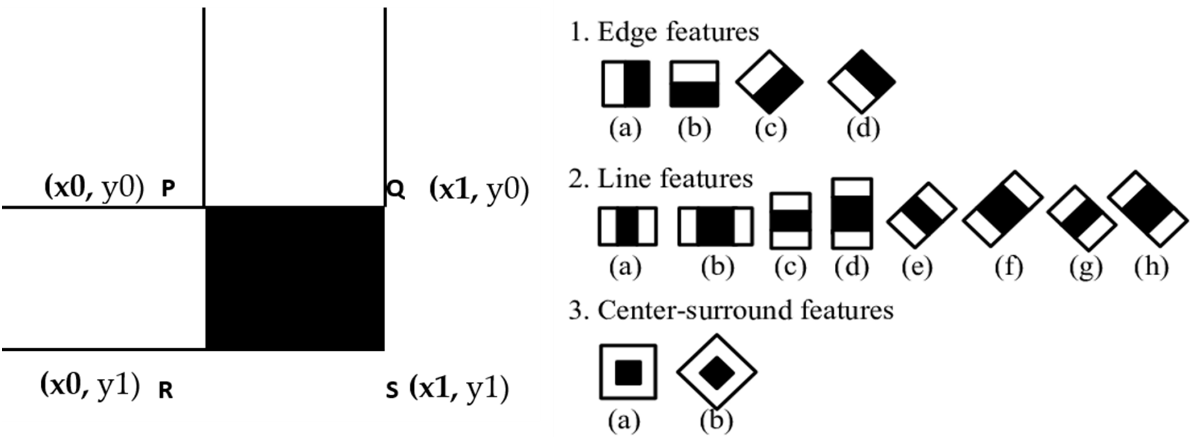
Figure 6. Integral image and Haar-like features.